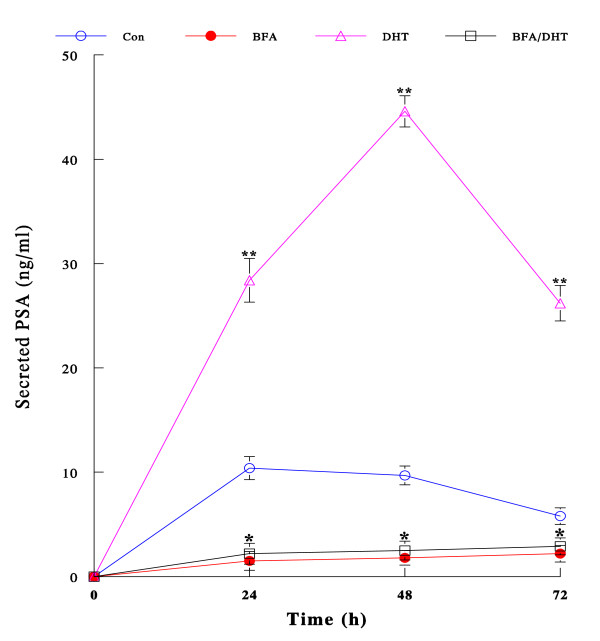
Effect of BFA on PSA secretion regulated by DHT. Cells were cultured with BFA (30 ng/ml), DHT (1 nM), or BFA/DHT combination for 24, 48, and 72 h. Spent media were collected at each time point and assayed for secreted PSA. The amount of PSA secreted was expressed by ng/ml and all data are mean ± SD from three independent experiments (*p < 0.05; **p < 0.005 compared with controls).